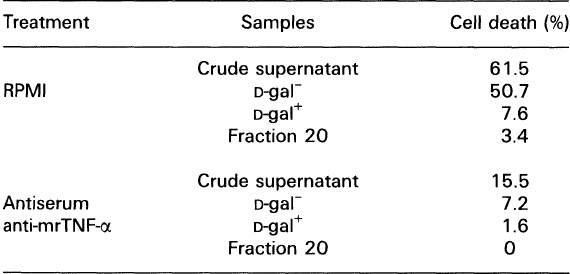
Table 1. Cytotoxic activity of the crude supernatant and chromatographic fractions on WEHI cells